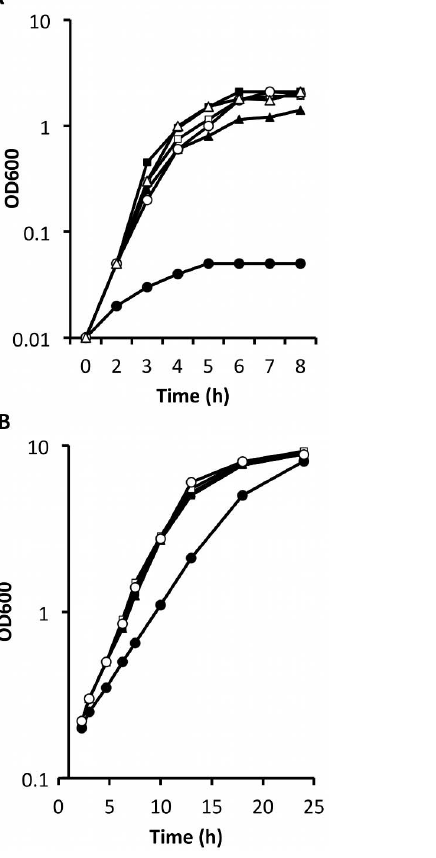
Figure 6. Growth phenotype of mtlD inactivated S.aureus . (A) Culture of strains in broth containing Mtl at 37 u C. Liv1023 (SH1000